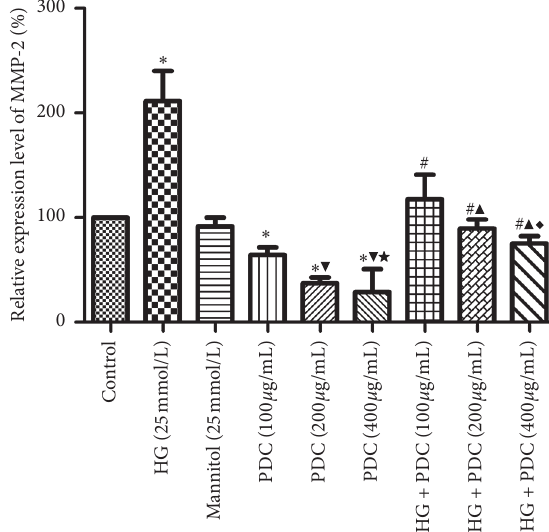
Figure 4: Effects of high glucose concentration and PDC on the mRNA expression of MMP-2 in HSF cells. HSF cells were incubated at high glucose (25 mmol/L) or PDC (100, 200, and 400 μ g/mL) for 48h. The total RNA of the cells was collected, and the mRNA expression of MMP-2 in the cells was detected by real-time quantitative PCR. All the data were expressed as x ± S ( n � 3). ∗ P < 0 . 05, compared with the control group; ▼ P < 0 . 05, compared with the Dendrobium polysaccharide (100 μ g/mL) group; ★ P < 0 . 05, compared with the Dendrobium polysaccharide (200 μ g/mL) group; # P < 0 . 05, compared with the high-glucose group; ▲ P < 0 . 05, compared with the high- glucose+ Dendrobium polysaccharide (100 μ g/mL) group; ◆ P < 0 . 05, compared with the high-glucose+ Dendrobium polysaccharide (200 μ g/mL)